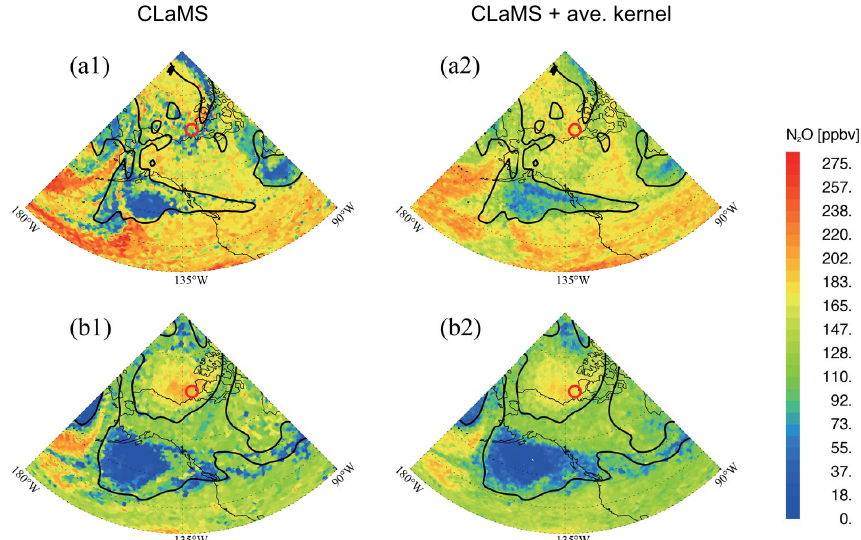
Figure A2. Spatial distribution of N 2 O on 20 February 2009, i.e. almost 1 month after the major SSW at θ = 550K (top row) and 650K (bottom row). Here the results of the reference run without and with the averaging kernel are shown in the left and right column, respectively. The black line denotes the vortex edge, the red circles are the noon-footprints calculated by the observed ACE profile through back and forward trajectory.